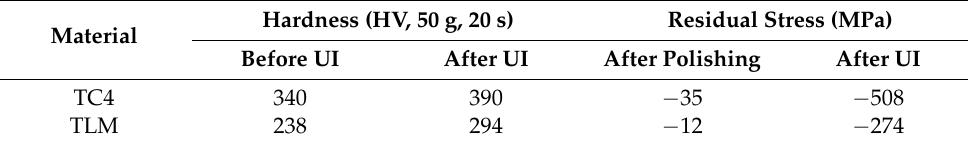
Table 3. Surface hardness and residual stress of TC4 and TLM.